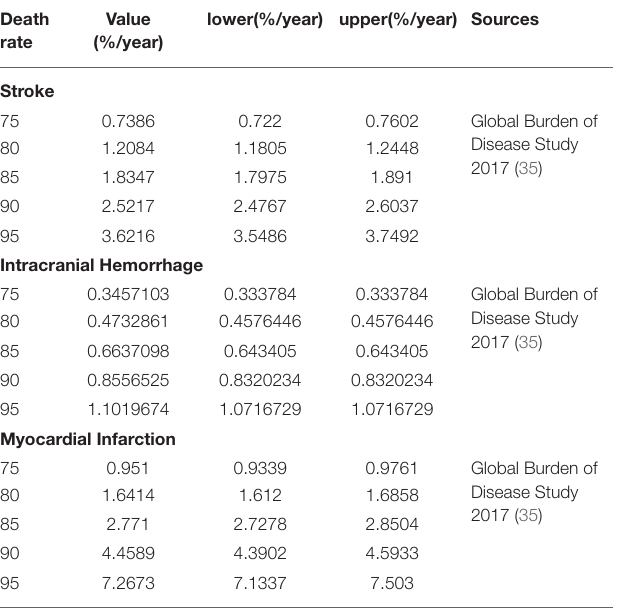
TABLE 2 | Annual long-term death rate at given age.